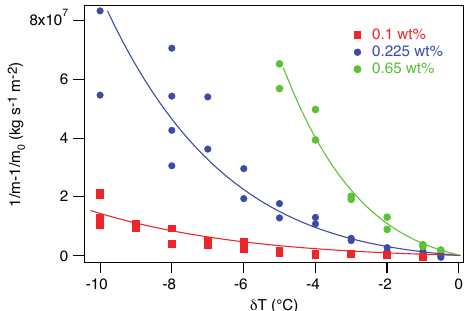
Figure 17. Shift between the reciprocal of the mobility and its value in pure 8CB as a function of temperature. The solid lines are the best fit with the model by taking δ V ∼ 27 nm 3 (adapted from Ref.